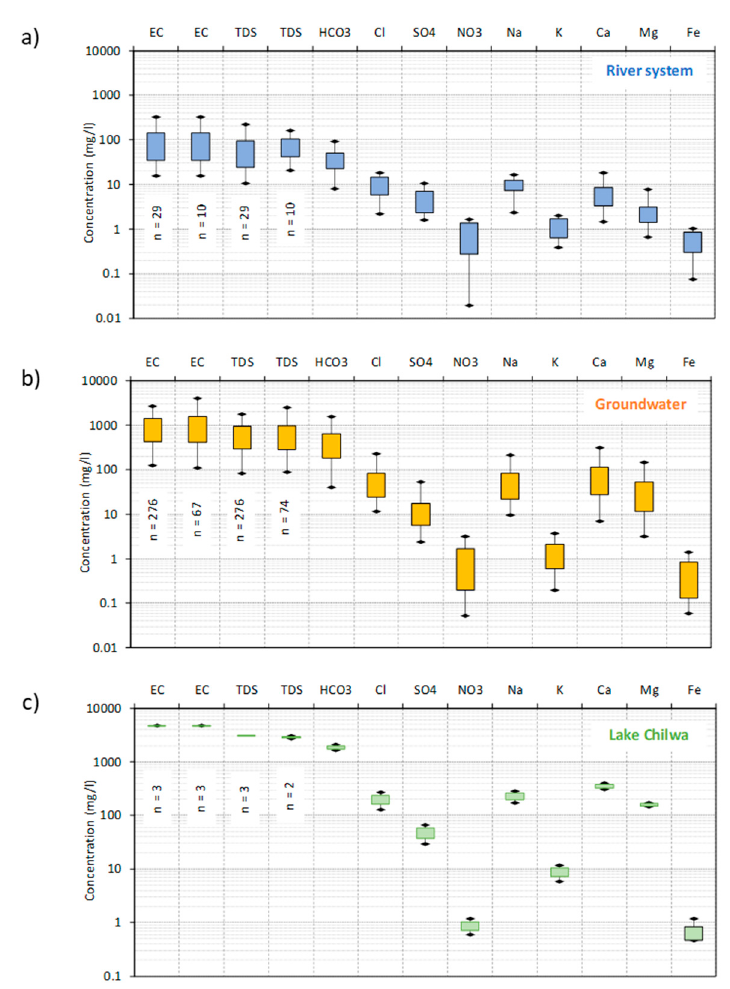
Figure 8. Observed hydrochemical interquartile plots for Phalombe District: ( a ) river water: ( b ) groundwater; and ( c ) Lake Chilwa. EC data are shown for site measurements for both the entire datasets and subset of samples analysed for major ions. TDS data are shown for all on-site measurements and a calculated TDS summed from laboratory ion concentrations analysed (smaller n number that also applies to the individual ion datasets).